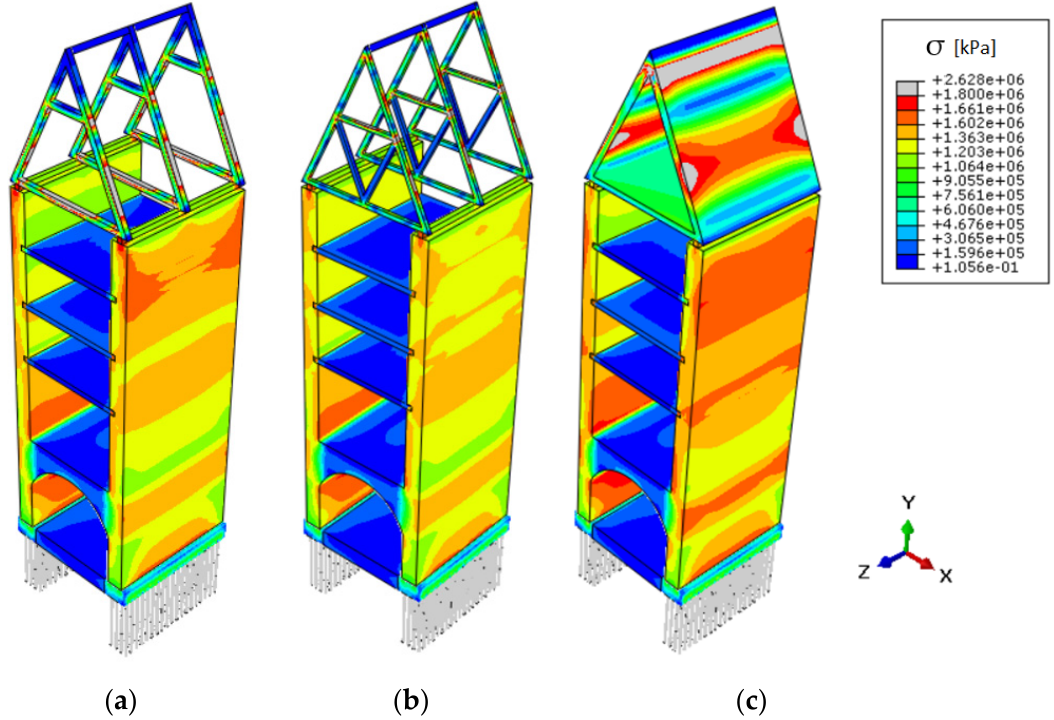
Figure 13. Numerical model of roof structures of modern tenement houses in Gdansk: ( a ) wooden rafter framing of one